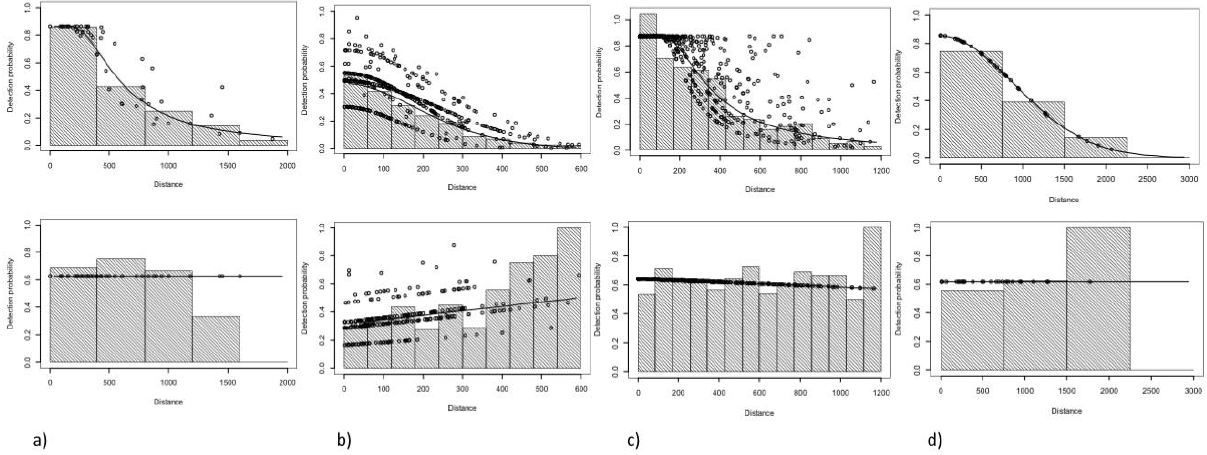
Figure 8. Detection function curves for pooled detections (top) and the conditional detection probabilities of platform 1 (bottom) for (a) killer whales, (b) harbour porpoises, (c) Lagenorhynchus spp., and (d) northern bottlenose whales.